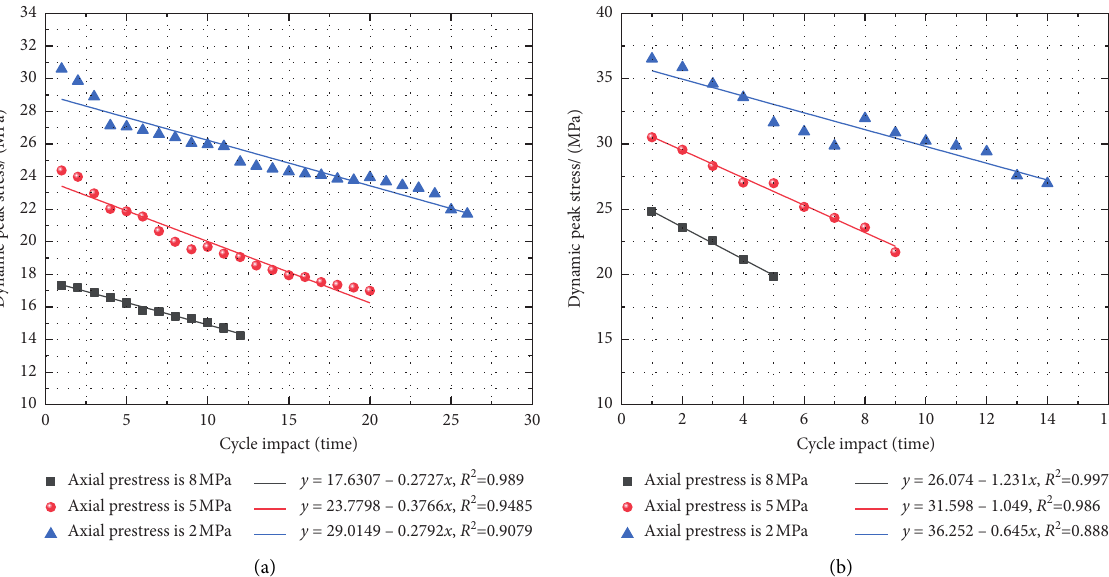
Figure 6: Relationship between dynamic peak stress and the number of impacts: (a) Zhaogezhuang burst-resistant coal specimens. (b) Qianqiu burst-prone coal